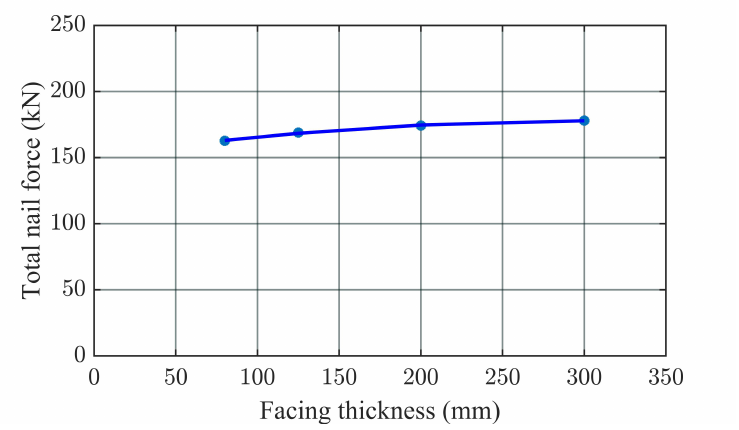
Figure 5. Total nail force recorded on the facing for each facing